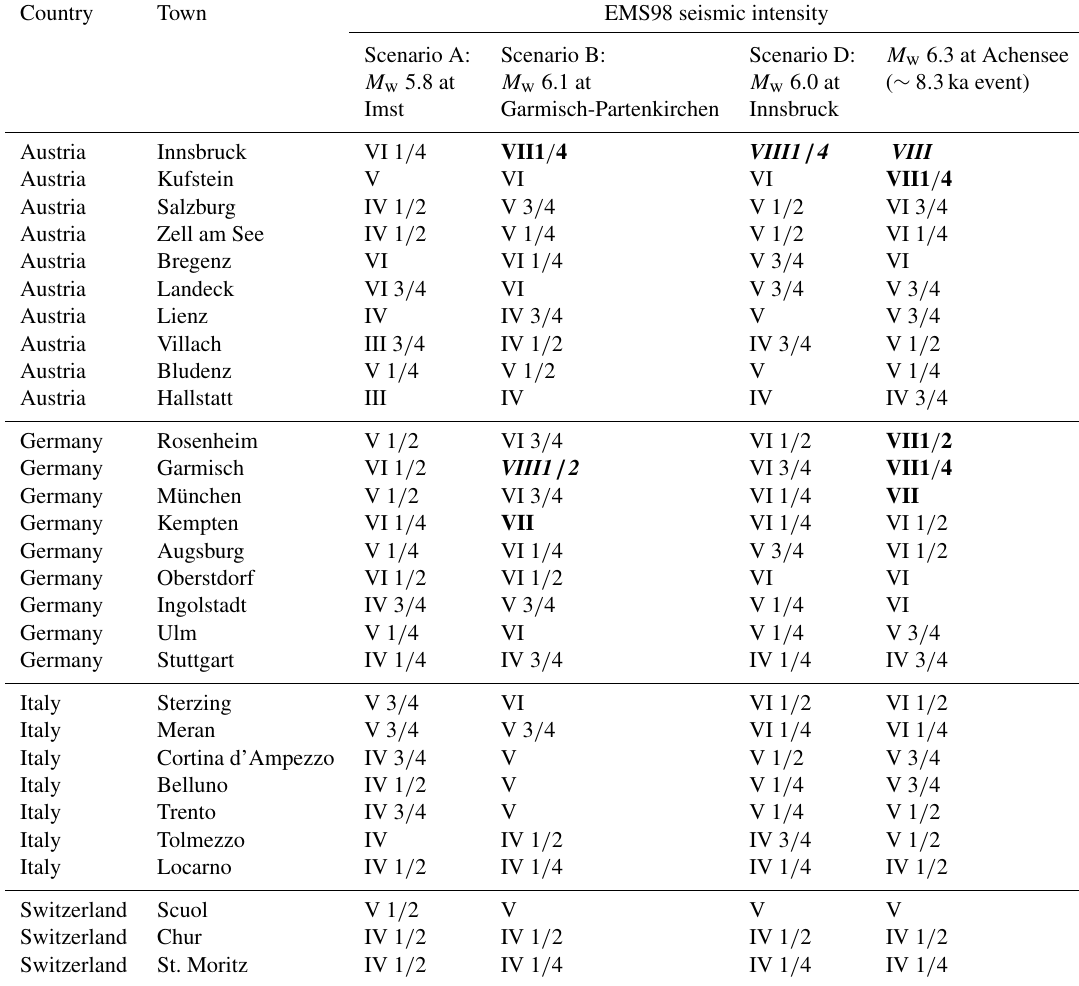
Table 2. Seismic intensities at surrounding major towns in Austria, Germany, Italy, and Switzerland for the paleo-earthquake scenarios shown in Figs. 6 and 7. Bold values indicate seismic intensities ≥ VII. Bold and italic values indicate seismic intensities ≥